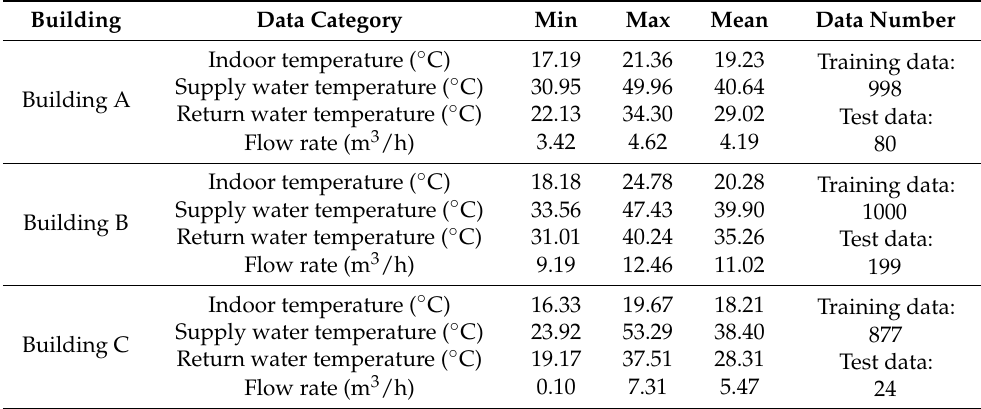
Table 3. The statistics of the three